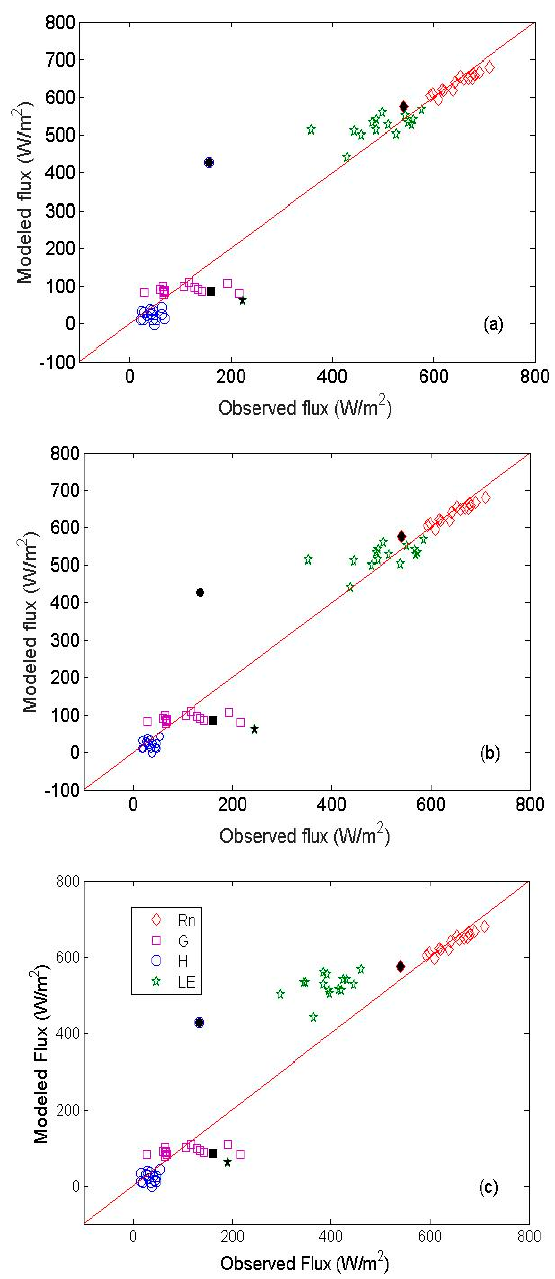
Figure 3. Comparison between measured and modeled flux components obtained by applying TSEB to WiDAS imagery. Plot ( a ) is enforcing closure with the BR method; ( b ) closure with the RE method; and ( c ) measured H (sensible hear flux) and LE (latent heat flux) without closure. The solid symbols are the modeled and observed flux components for Tower Site 4 (EC4). Rn denotes net radiation, and G denotes soil heat